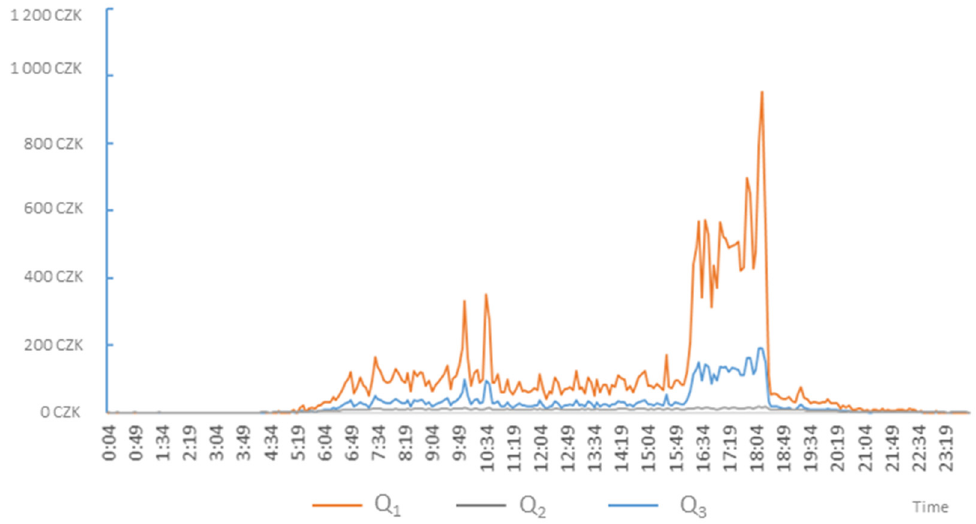
Figure 6. An example demonstrating the split of the cost of congestions (in CZK) to particular contributing factors Q_i during the